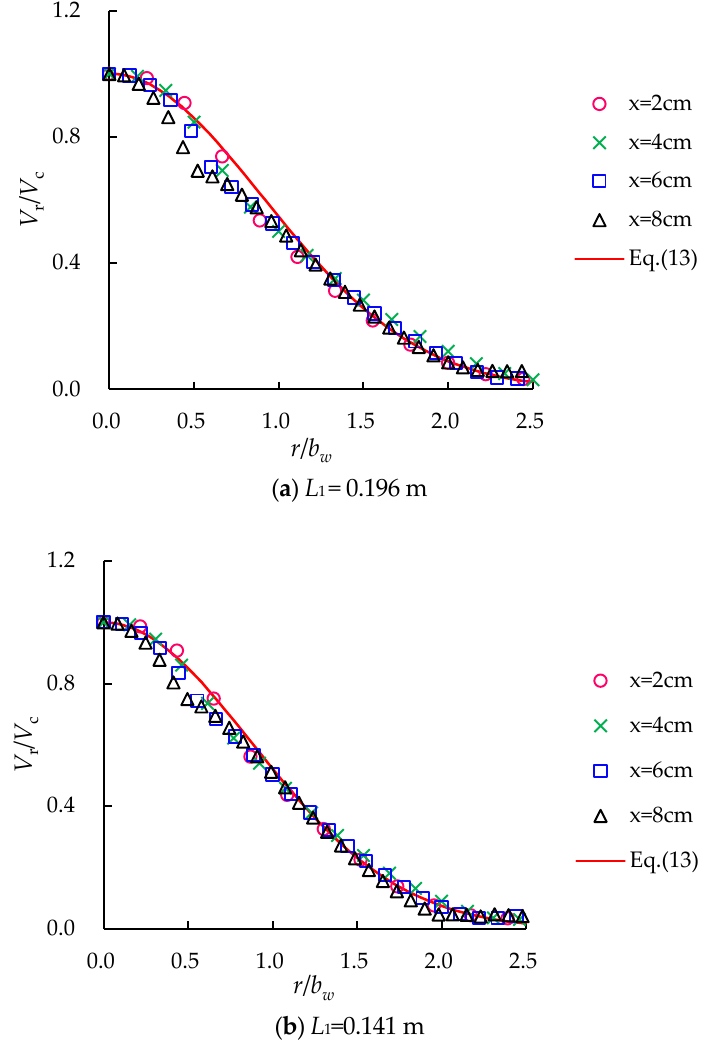
Figure 10. The computational V r / V c relationship with r / b w for V 0 = 2 m/s and ( a ) L 1 = 0.196 m and ( b ) L 1 = 0.141 m.